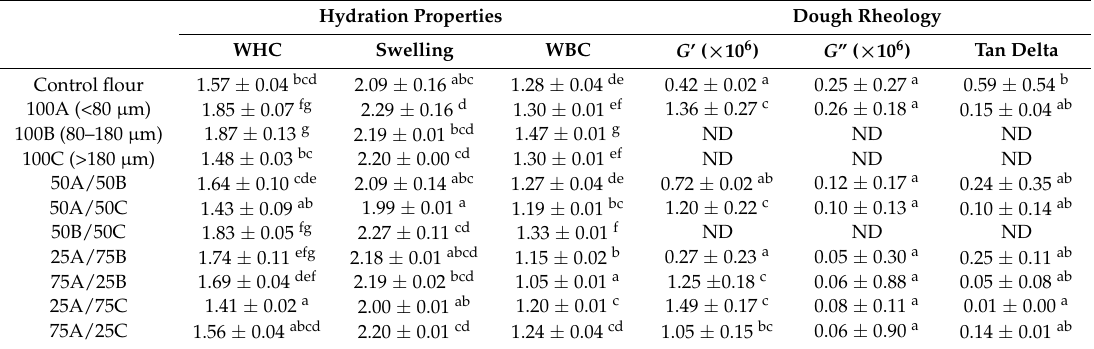
Table 3. Maize flour, maize flour fractions and their combinations: hydration properties and cookie dough